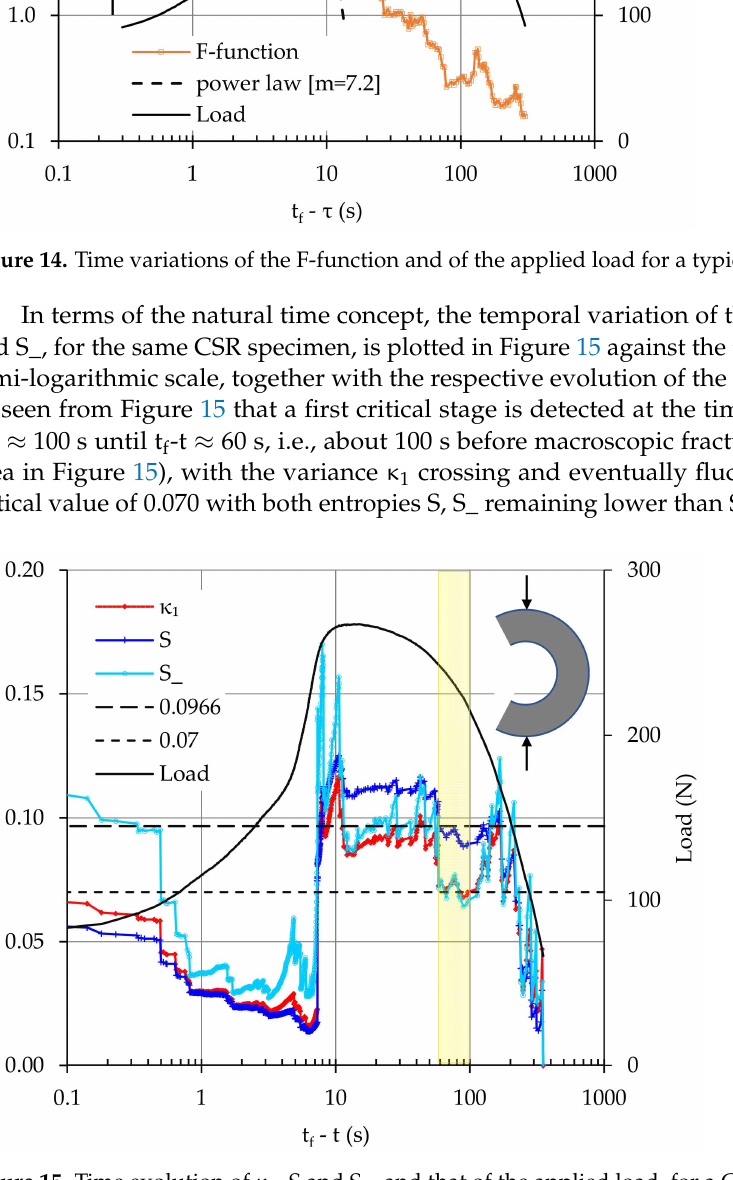
Figure 15. Time evolution of κ 1 , S and S_, and that of the applied load, for a CSR specimen. The electrical activity, for the specific specimen, is explored now in terms of the PSC recorded versus the t f -t parameter, adopting a semi-logarithmic manner, together with the respective evolution of the applied load (Figure 16). It can be seen from this figure that the temporal evolution of the PSC obeys the power law of Equation (15) from the time instant t f -t ≈ 18 s until the instant t f -t ≈ 5 s. The exponent m is now equal to m = 0.60. Then the PSC decreases steadily until the specimen’s macroscopic